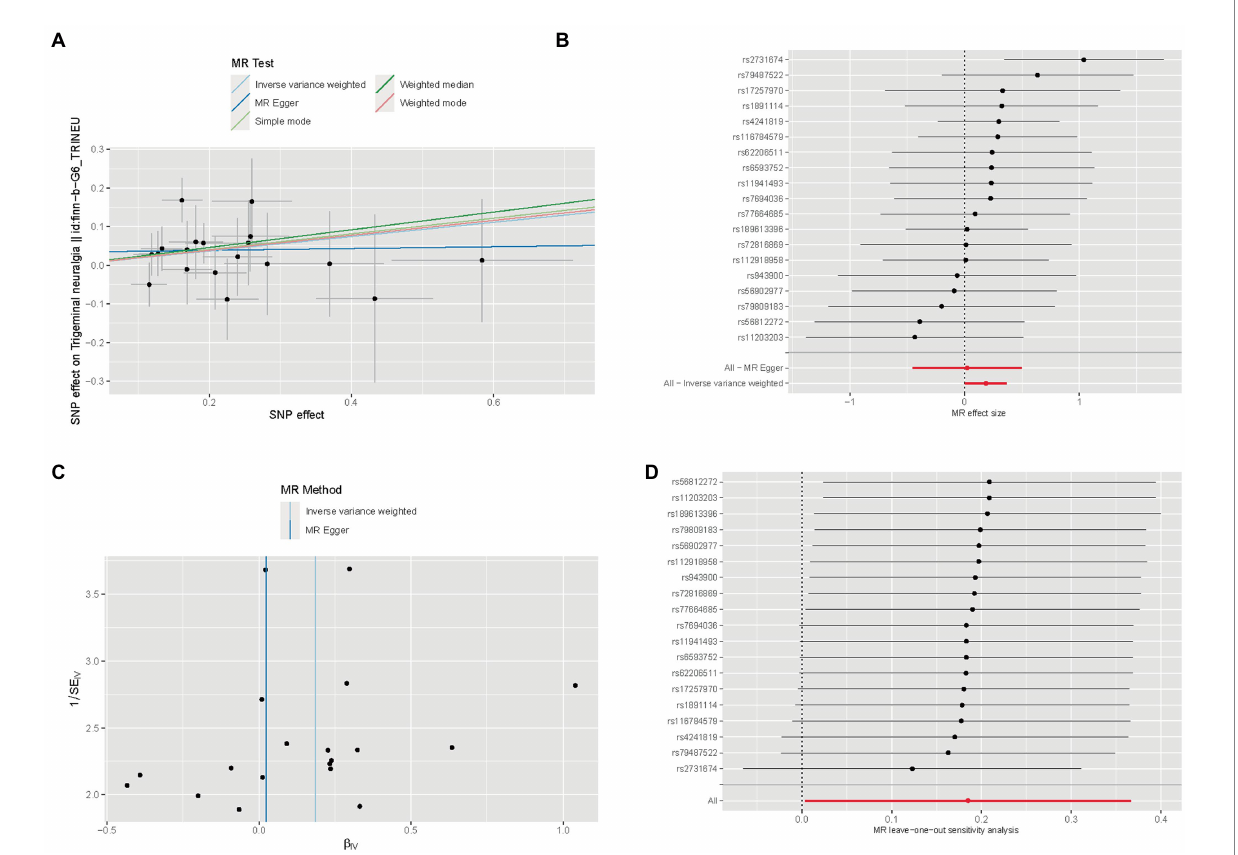
FIGURE 7 Mendelian randomization study results. (A) Scatter plot showing the causal effect of IL2 on the risk of trigeminal neuralgia. (B) Forest plot showing the causal effect of each SNP on the risk of trigeminal neuralgia. (C) Funnel plots to visualize overall heterogeneity of MR estimates for the effect of IL2 on trigeminal neuralgia. (D) Leave-one-out plot to visualize causal effect of IL2 on trigeminal neuralgia risk when leaving one SNP